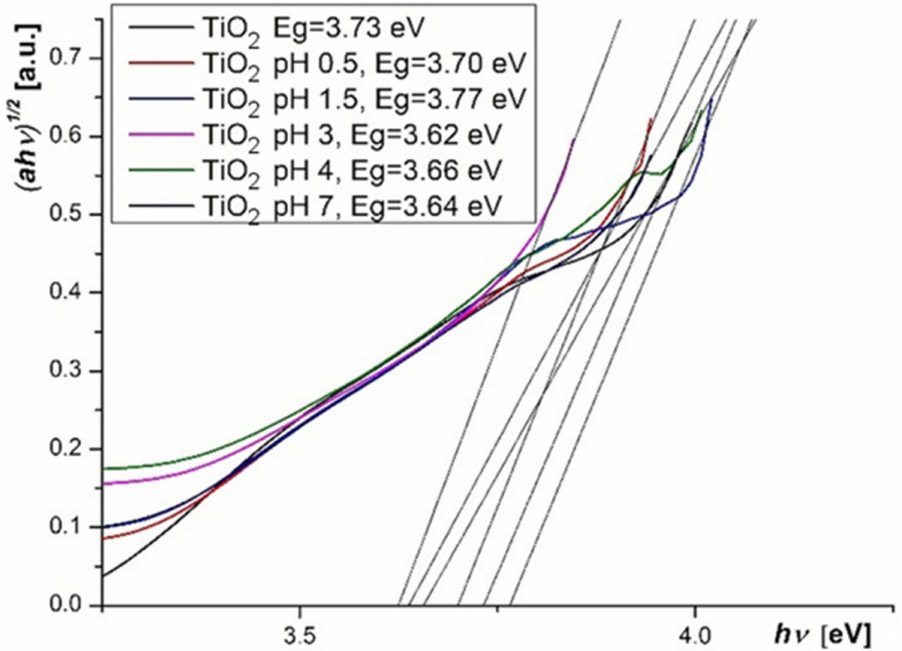
Figure 11. Tauc plots for TiO 2